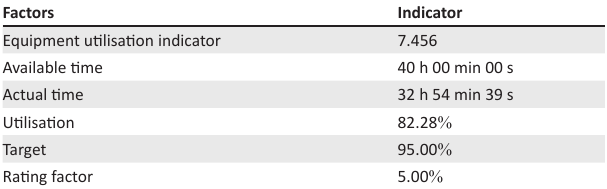
TABLE 26: Equipment